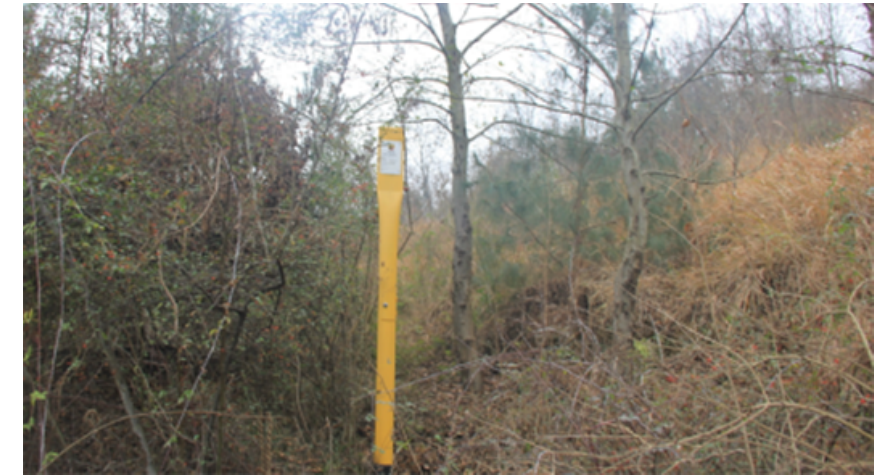
Figure H2. Vegetation environment of a pipeline section in the study